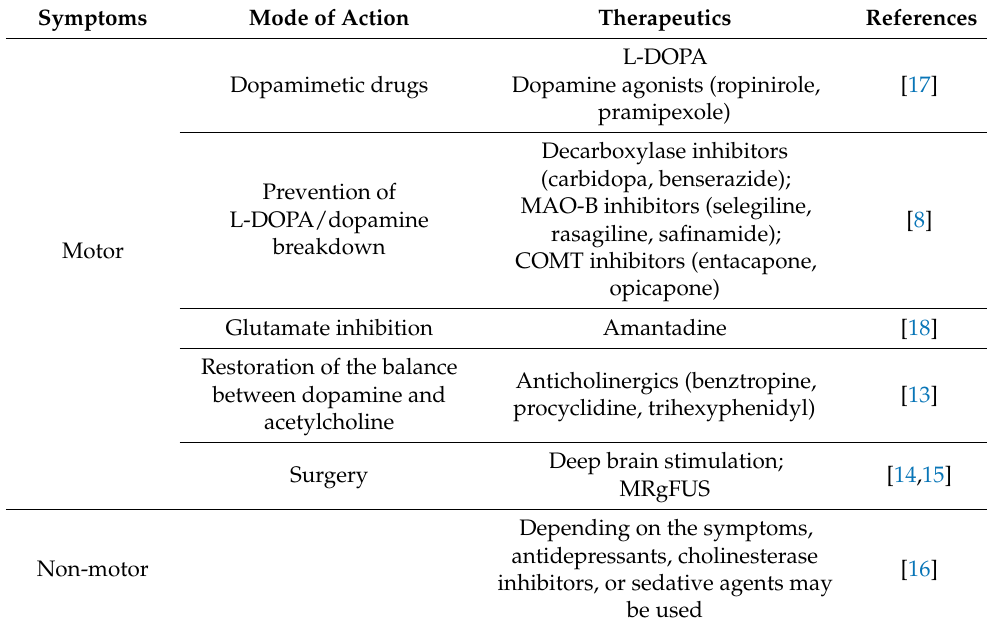
Table 1. Current approaches used in PD